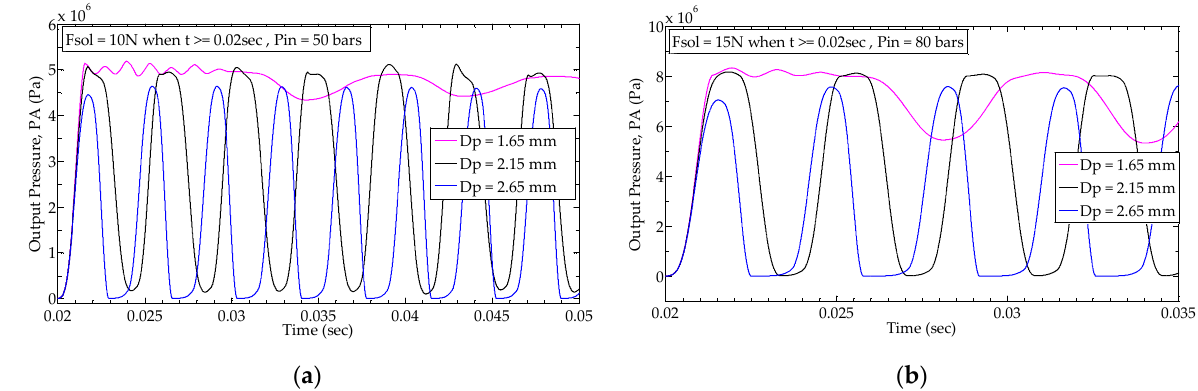
Figure 7. Transient response of output pressure for different sizes of pin diameter: ( a ) When inlet pressure is 50 bar and actuating force is 10N; ( b ) When inlet pressure is 80 bar and actuating force is 15 N.